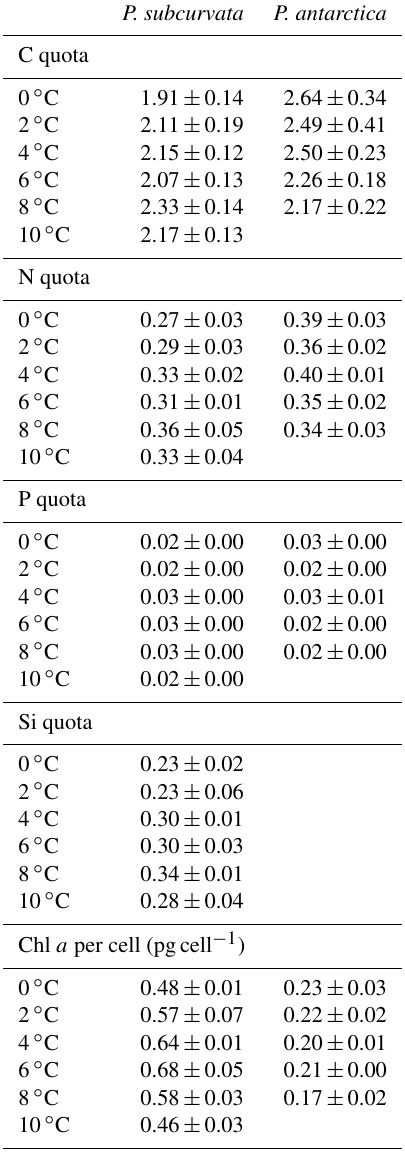
Table 3. The effects of temperature on the C quota (pmolcell − 1 ) , N quota (pmolcell − 1 ) , P quota (pmolcell − 1 ) , Si quota (pmolcell − 1 ) , and Chl a per cell (pgcell − 1 ) of P. subcurvata and P. antarctica. Values represent the means and errors are the standard deviations of triplicate bottles.